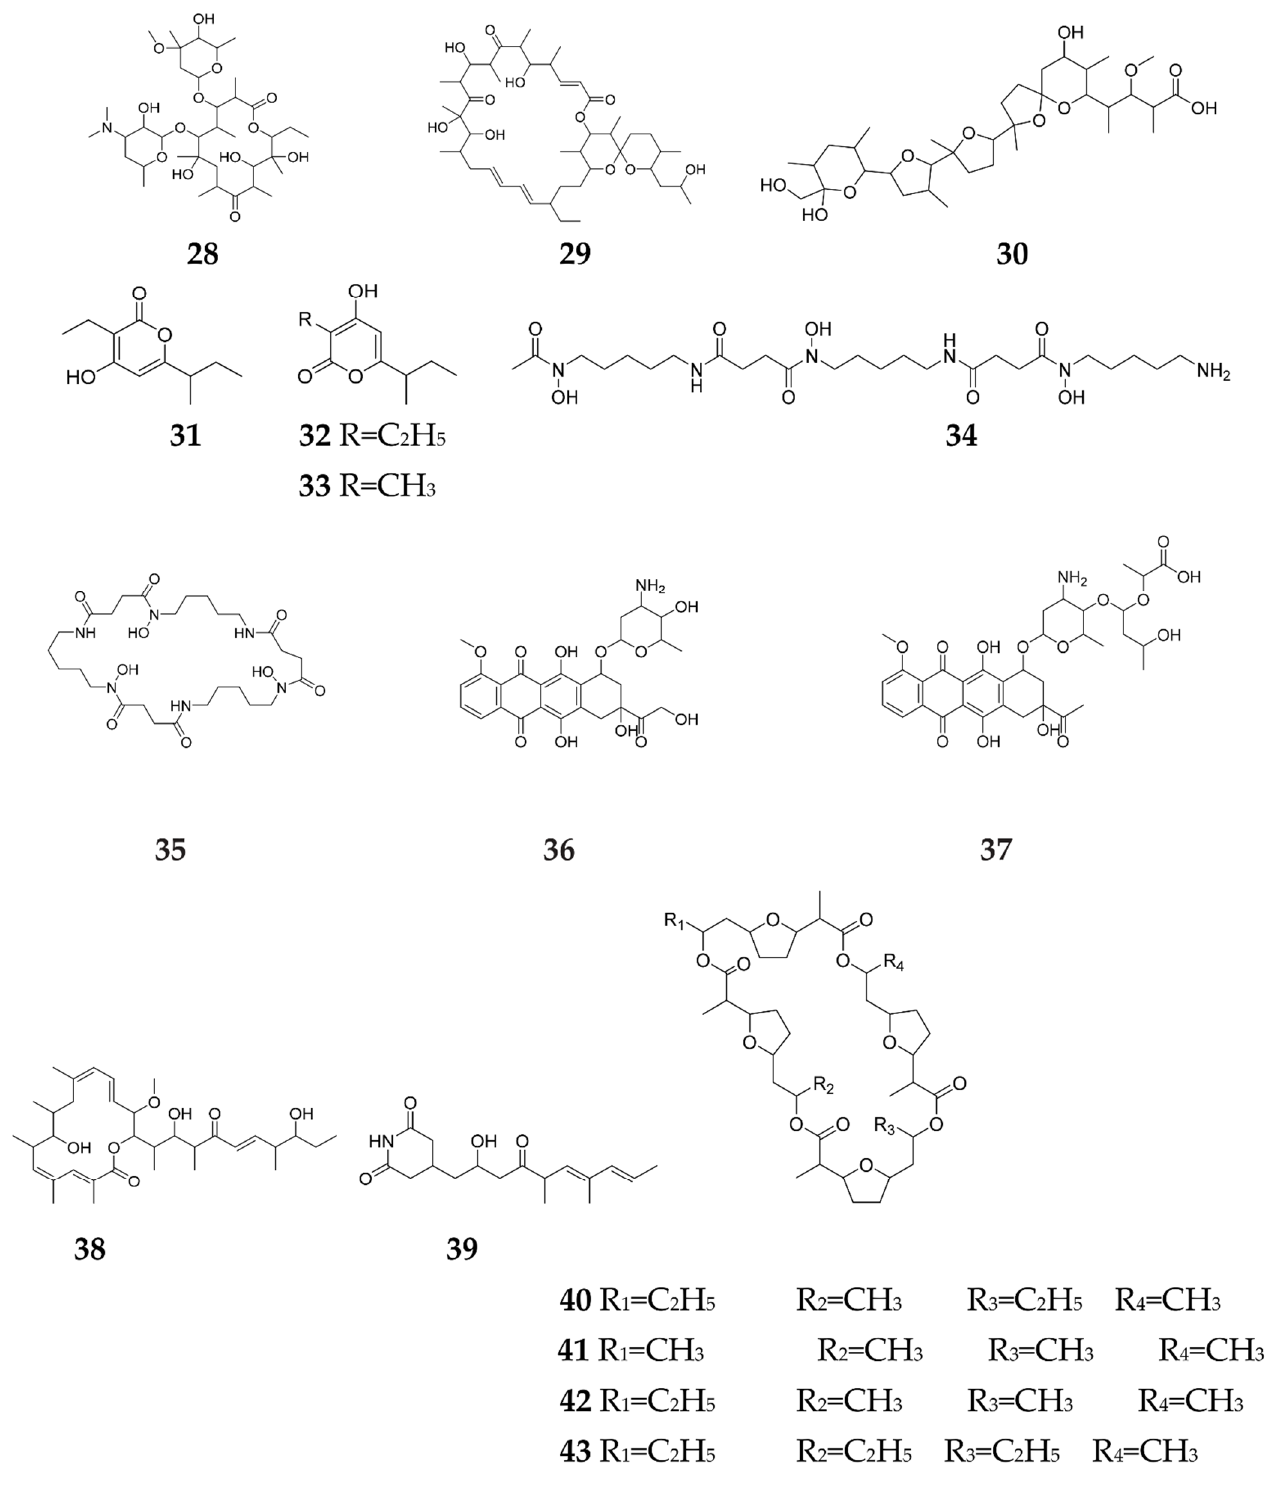
Figure 5. Secondary metabolites elicited by antibiotic remodeling compounds (ARCs).